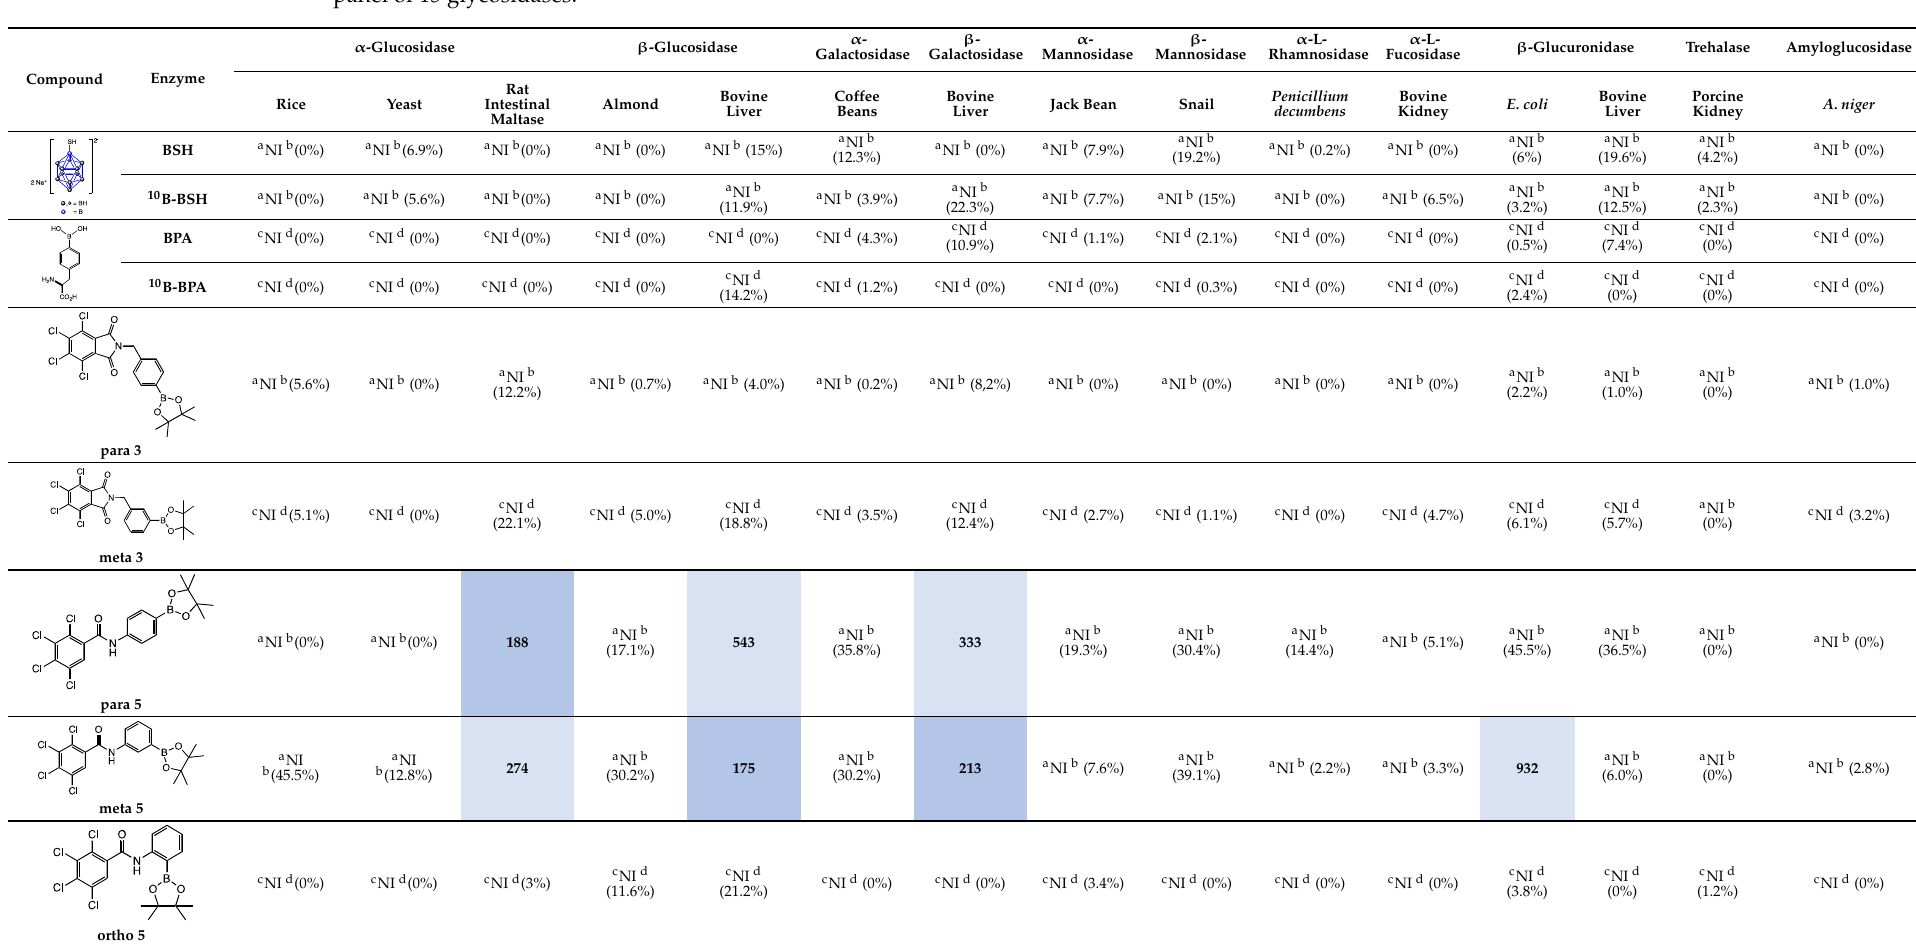
Table 1. Glycosidase inhibition studies from laboratory 1. Percentage inhibition data and IC 50 values (on coloured background) for the most potent activities in a panel of 15 glycosidases. Compound Enzyme